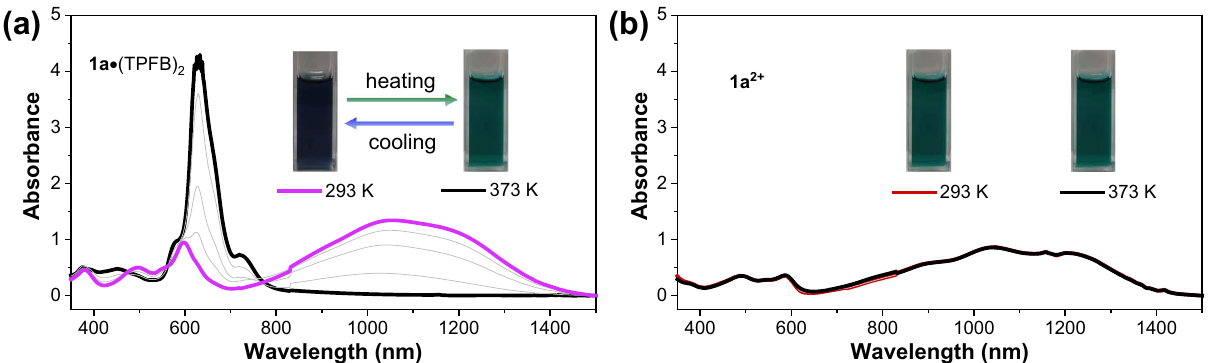
Fig. 7 Variable temperature UV-vis-NIR absorption of acid-base adducts and dications. Variable temperature absorption of ( a ) 1a (cid:129) (TPFB) 2 and ( b ) 1a 2 + in C 2 H 2 Cl 4 (14 μ M).